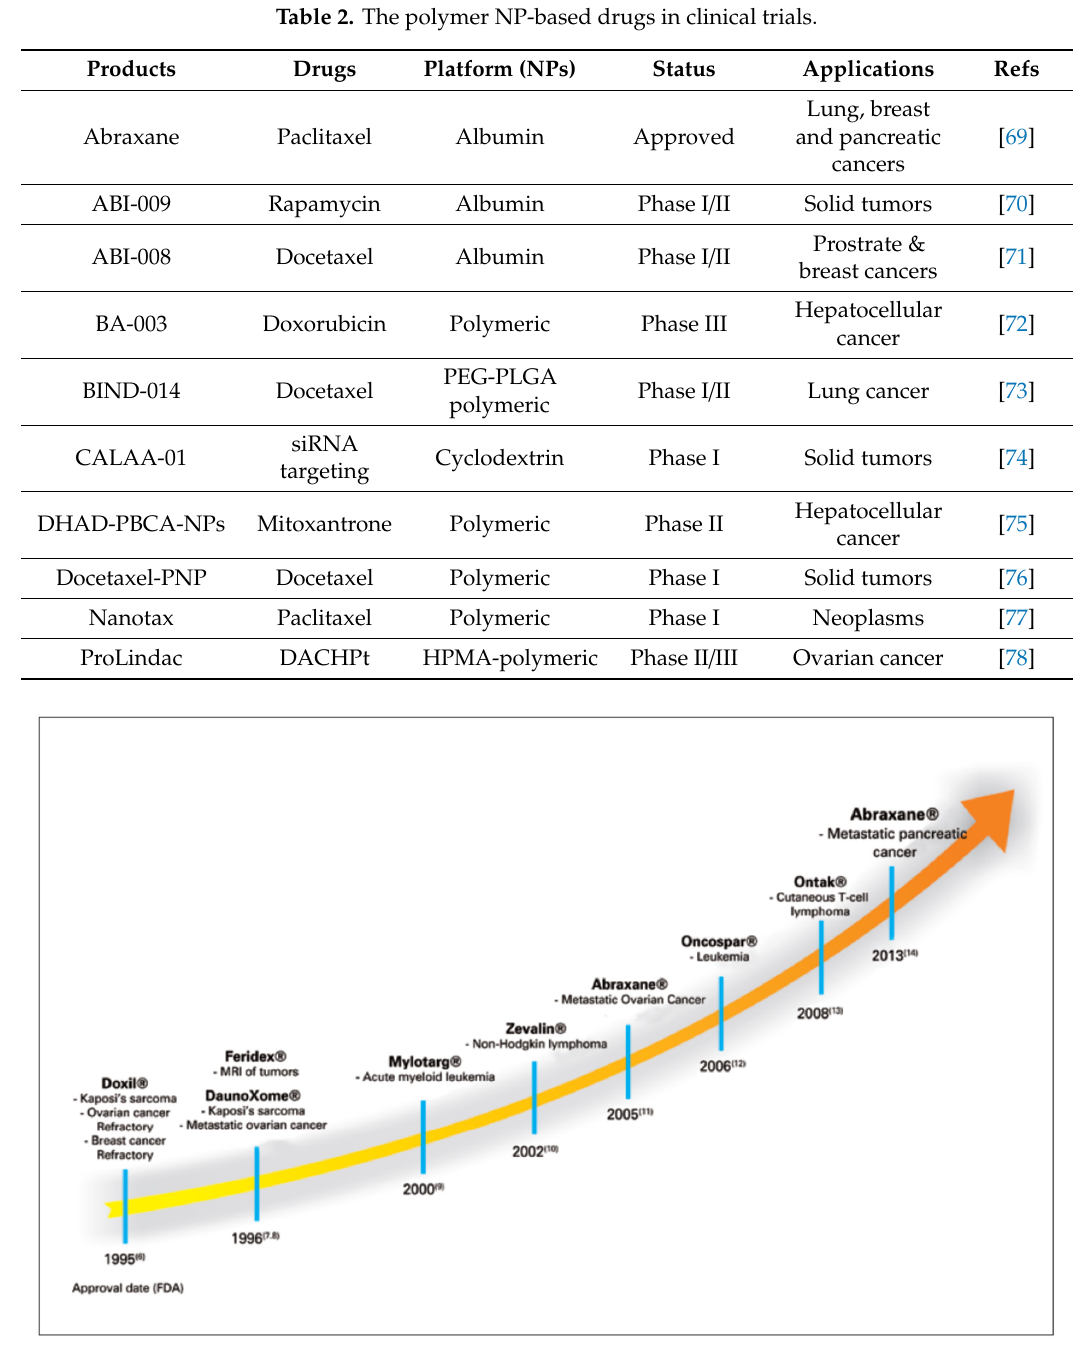
Figure 3. The timeline of the development of polymeric NPs based drugs for cancer treatment [79].